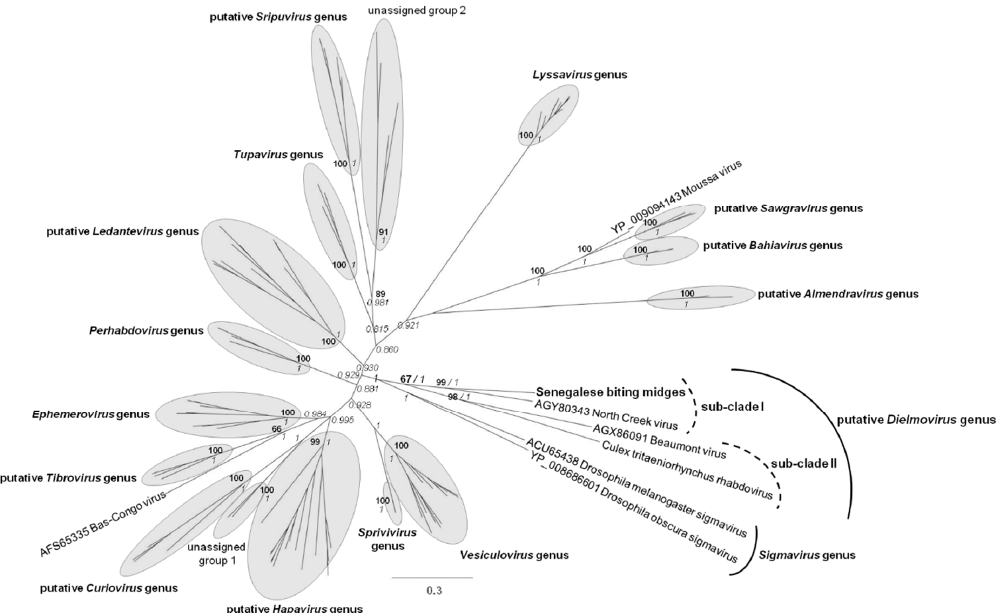
Figure 5. Phylogenetic analysis of Dielmovirus genus compared to other Rhabdoviridae . Phylogenetic